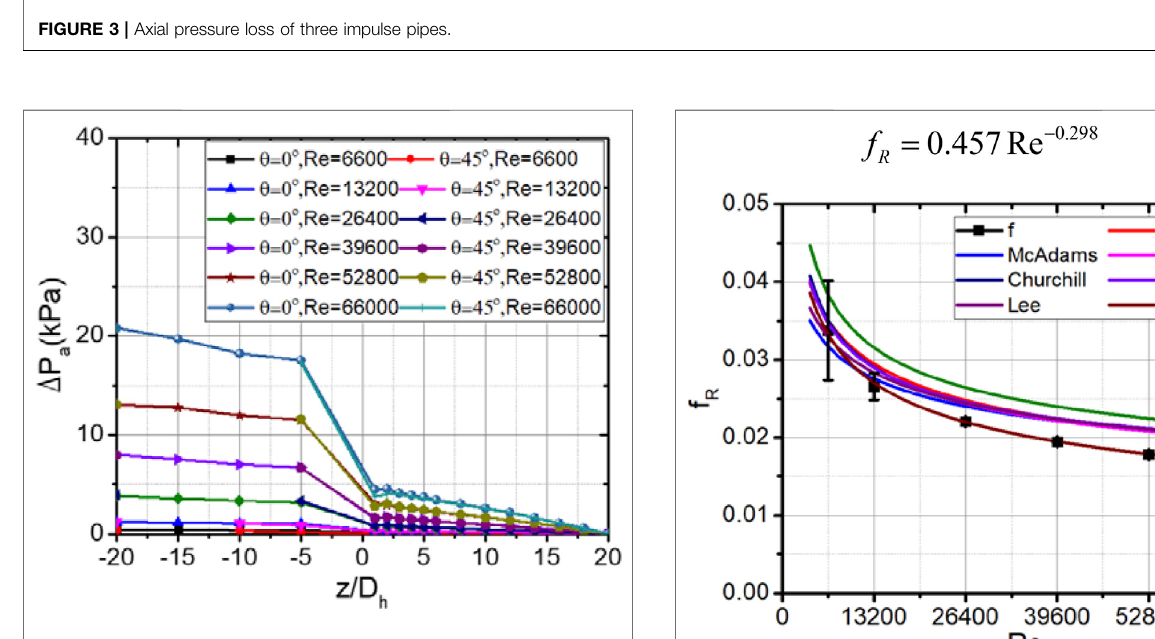
FIGURE 4 | Averaged axial pressure loss of three impulse pipes.